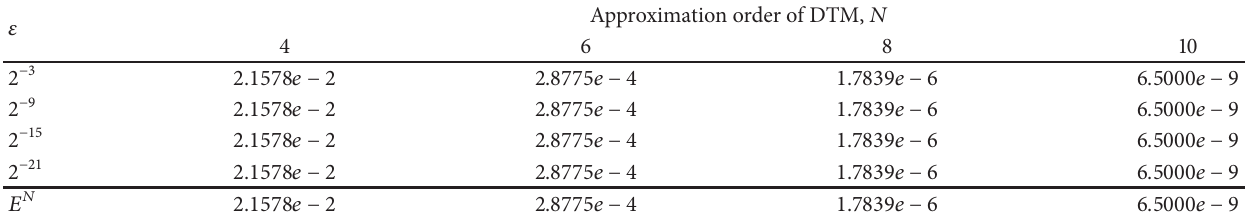
Table 7: Maximum pointwise errors 𝐸 𝑁 𝜀 and 𝐸 𝑁 for the second derivative solution 𝑦 2, ap of Example